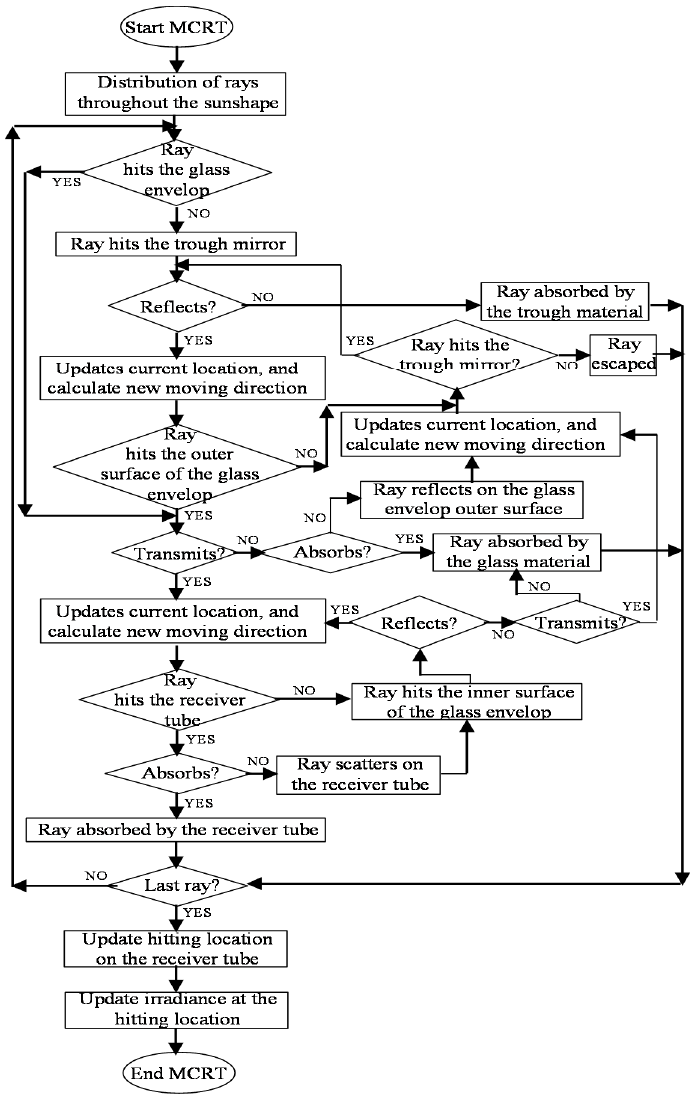
Figure 2. Framework for the Monte Carlo ray tracing model of Parabolic Trough Collector (PTC).